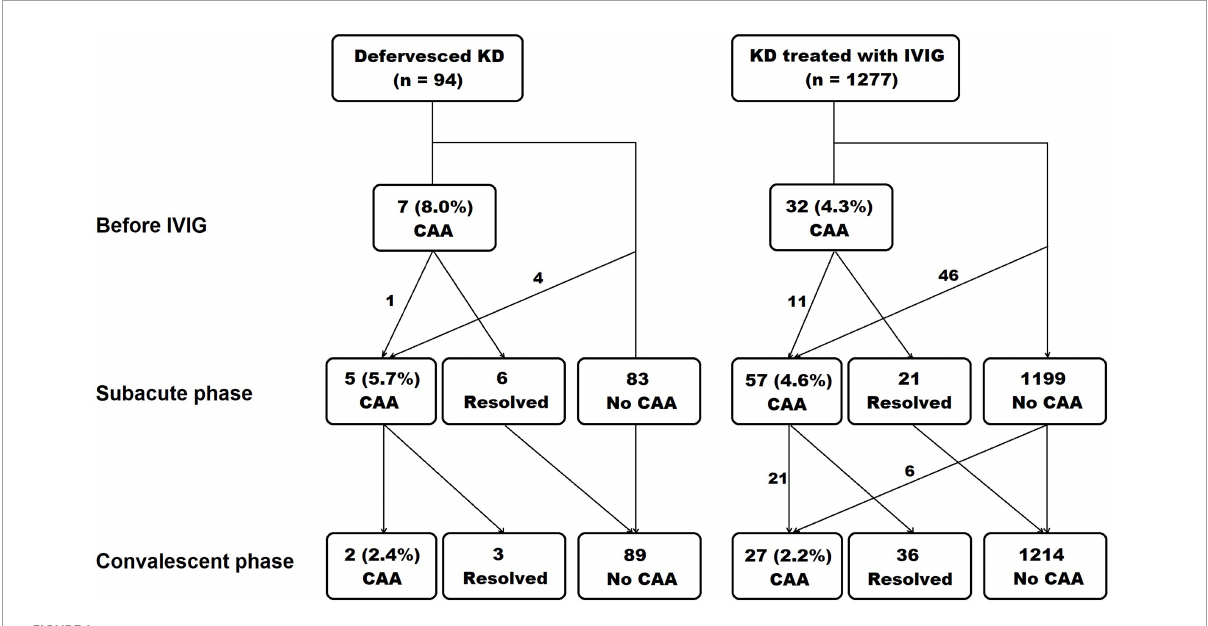
FIGURE1 Occurrence of coronary artery aneurysm in each phase of Kawasaki disease. The echocardiography was done at diagnosis and before intravenous immunoglobulin administration, at subacute phase, and at convalescent phase. KD, Kawasaki disease; IVIG, intravenous immunoglobulin; CAA, coronary artery aneurysm.